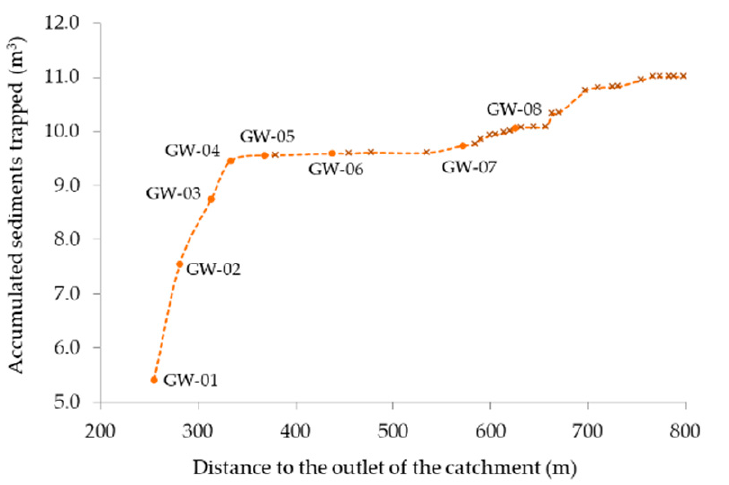
Figure 9. Accumulated sediments trapped at each check dam plotted against the distance to the outlet of the catchment. Note that the line shows the sediments trapped at each check dams plus the sediments trapped downstream of that specific check dam.